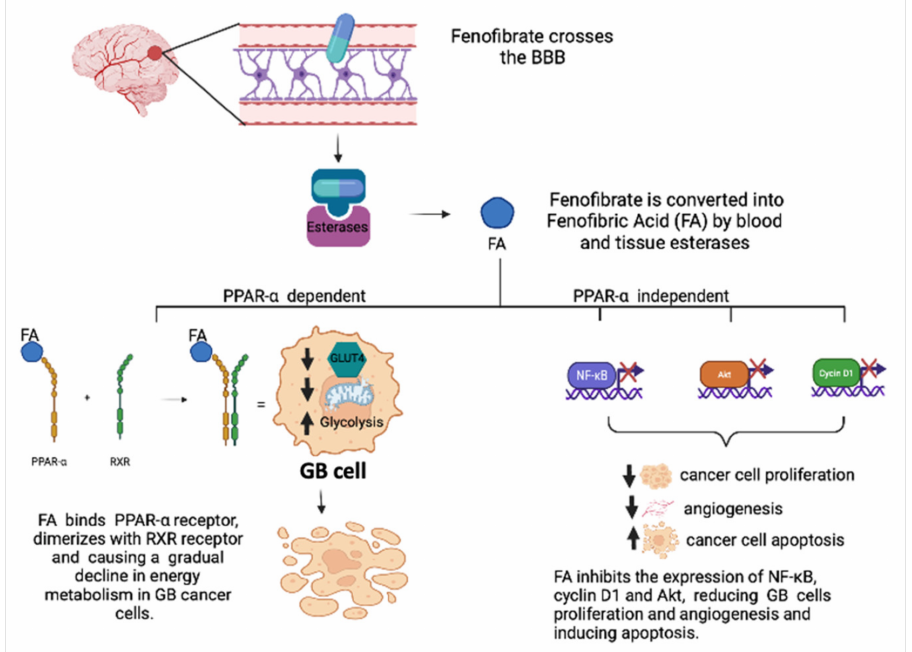
Figure 4. An exemplified overview of fenofibrate’s PPAR-dependent and PPAR-independent mecha- nisms of action in GB tumoral